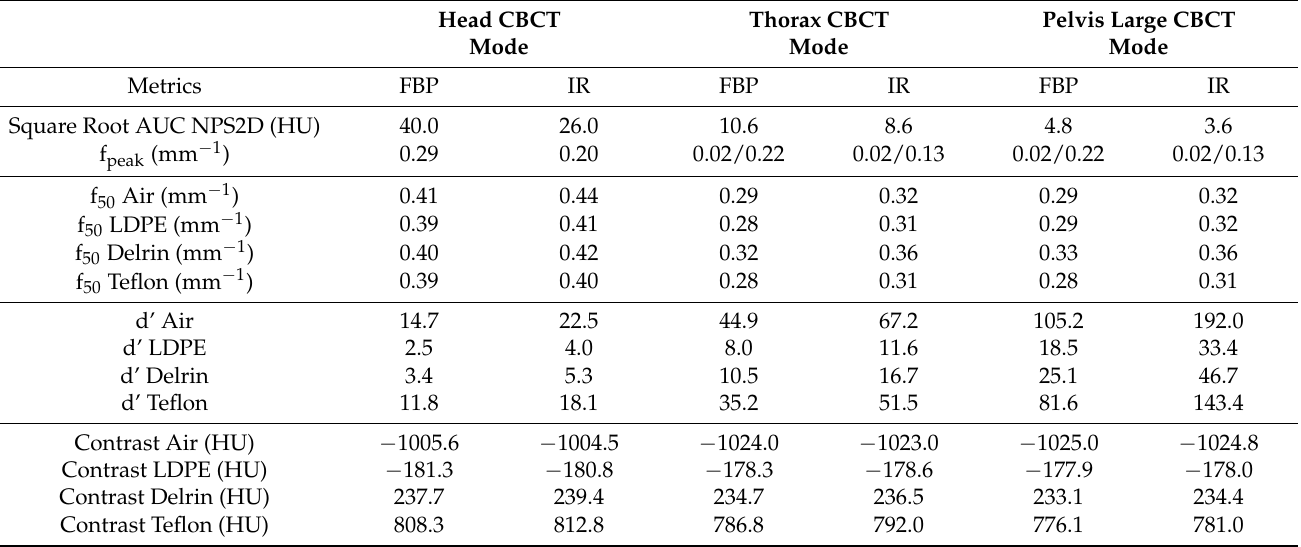
Table 2. Noise power spectrum, task-based transfer function, contrast values and detectability index outcomes obtained for all CBCT acquisition modes and reconstruction types.